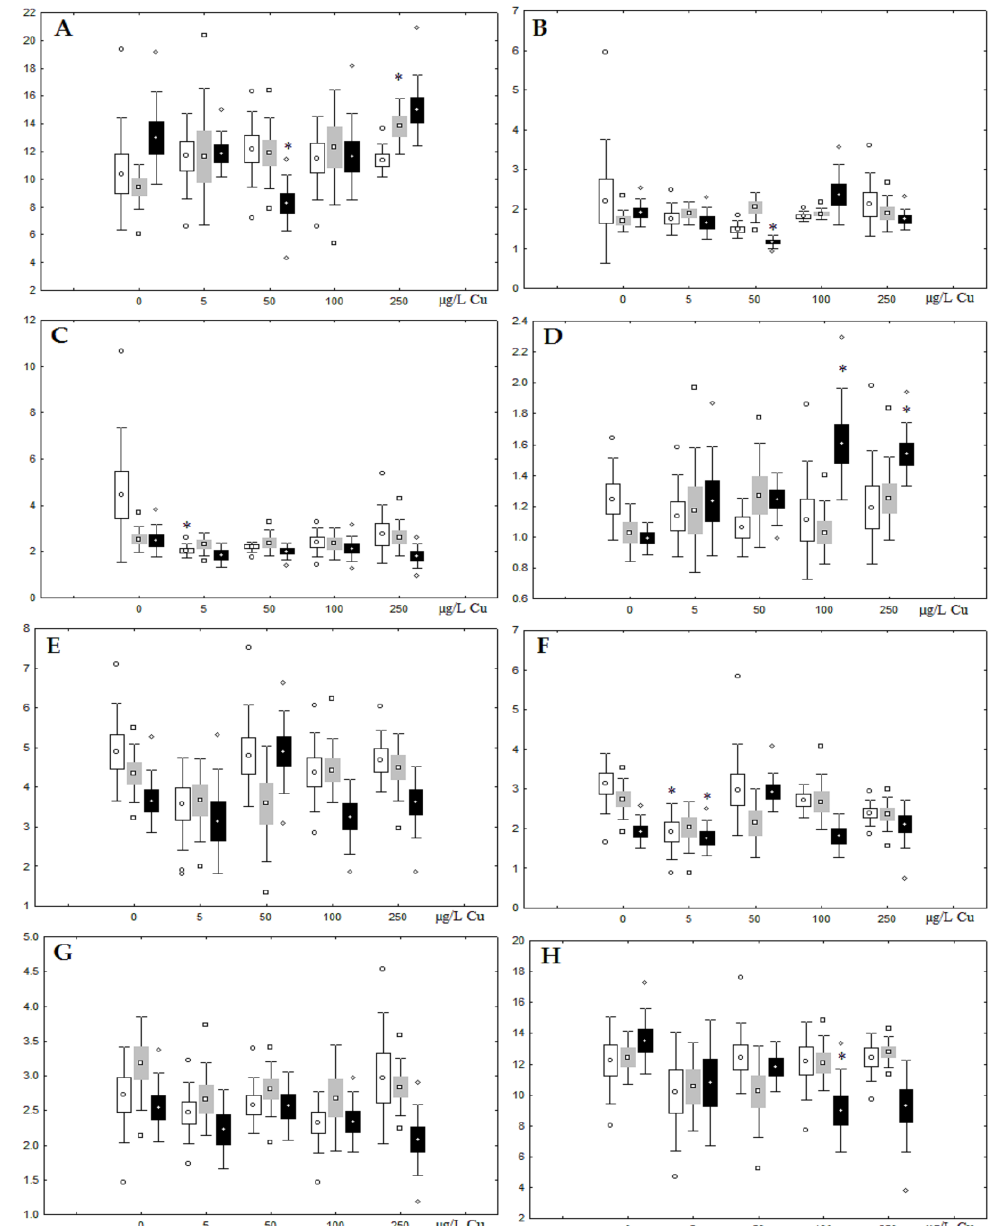
Figure 10. Changes in some dominated fatty acids in phospholipids: ( A ) 16:0, ( B ) 18:0, ( C ) 18:1n-9, ( D ) 20:1n-9, ( E ) 20:5n-3, ( F ) 22:6n-3, ( G ) 18:2n-6 and ( H ) 20:4n-6 in phospholipids of digestive glands of A. cygnea under experimental copper effects: white box—day 1 of the experiment; grey box—day 3 of the experiment; black box—day 7 of the experiment. *—significant results in comparison with control (0 µ g/L Cu). Differences were estimated using the nonparametric Kruskal–Wallis test; p < 0.05.